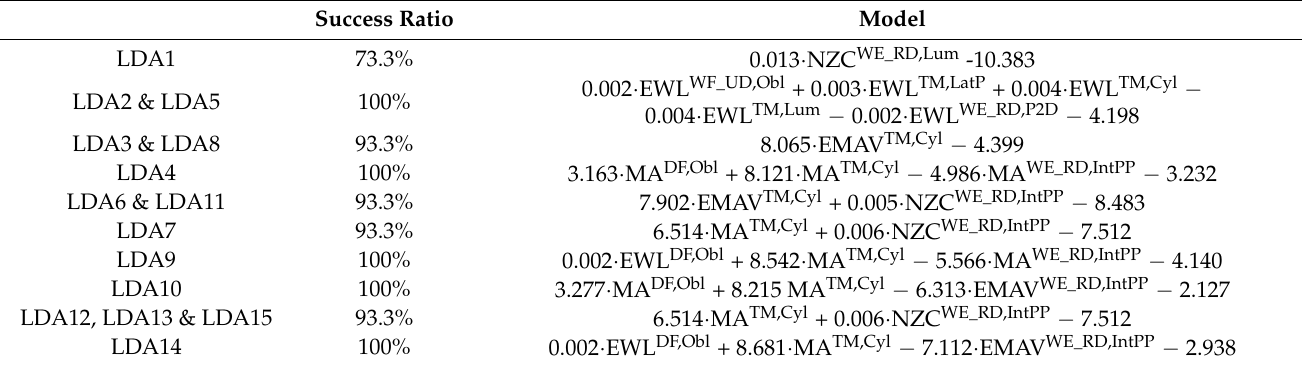
Table 5. The success ratios and models obtained from the different performed LDAs. Success